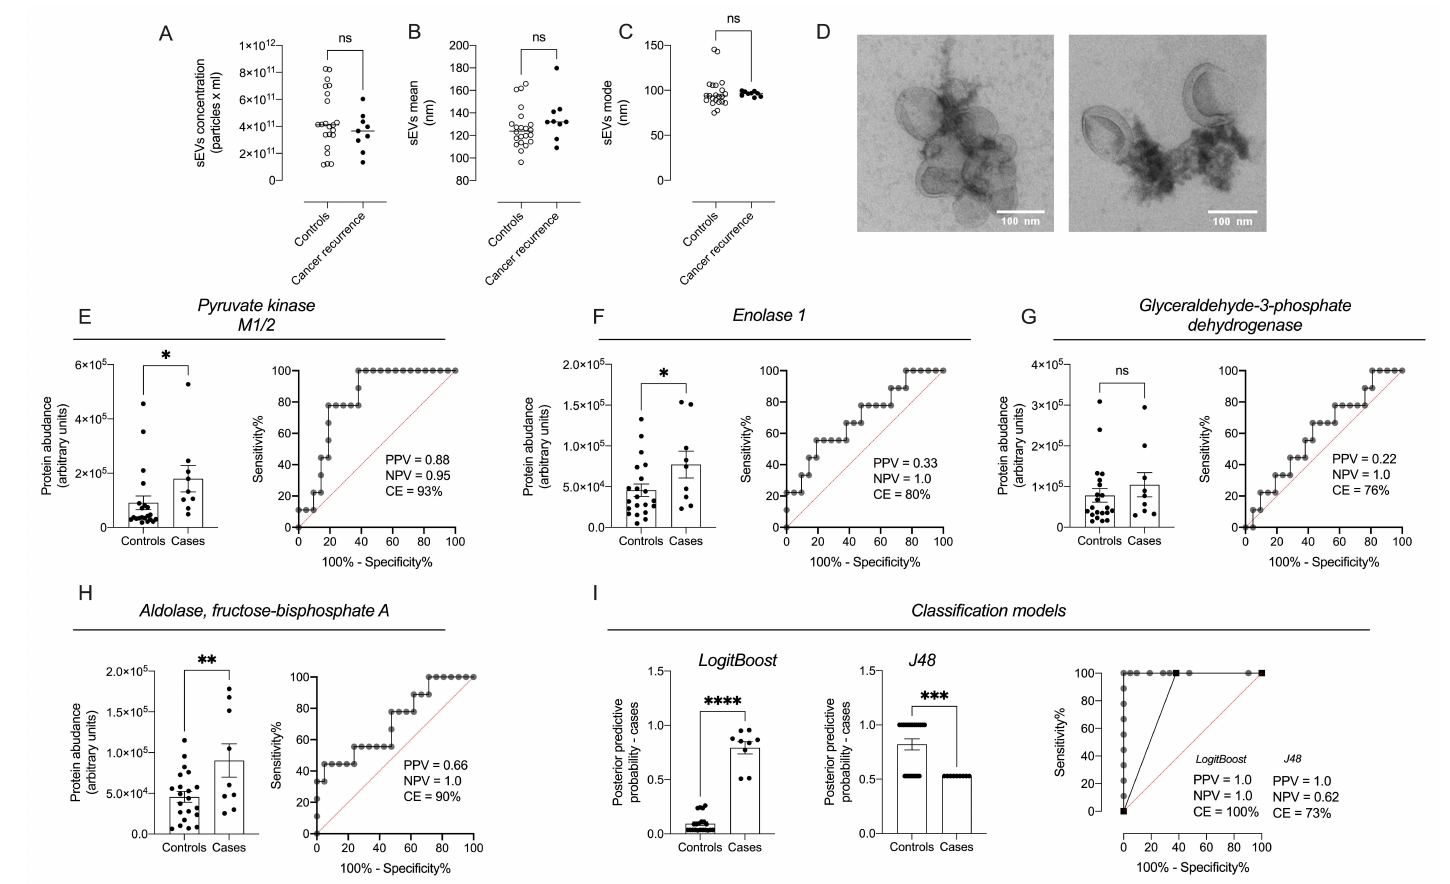
Figure 10. Receiver operating characteristic (ROC) curves illustrating the ability of proteins within sEVs to distinguish patients with cancer recurrence. sEVs were isolated from plasma obtained from patients with cancer recurrence and control. sEVs were characterised uisng nanoparticle tracking analysis by ( A ) concentration; ( B ) mean; ( C ) mode; and ( D ) electron microscopy. The levels of selected proteins, ( E ) pyruvate kinase M1/2; ( F ) enolase 1; ( G ) glyceraldehyde-3-phosphate dehydrogenase; and ( H ) aldolase, fructose-bisphosphate were quantified by SWATH analysis. In ( E – H ), left: levels of pyruvate kinase M1/2, enolase 1, glyceraldehyde-3-phosphate dehydrogenase, or aldolase, fructose-bisphosphate ( A ); and right: ROC curve for each protein. ( I ) Classification model based on the quantification of all proteins in sEVs and developed using LogitBoost regression analysis, or J48 decision tree model. PPV = positive predicted values; NPV = Negative Predictive Values; CE: classification Efficiency. * p < 0.05, ** p < 0.005, *** p < 0.0005 and **** p < 0.0001 for cases vs. controls. Ns =